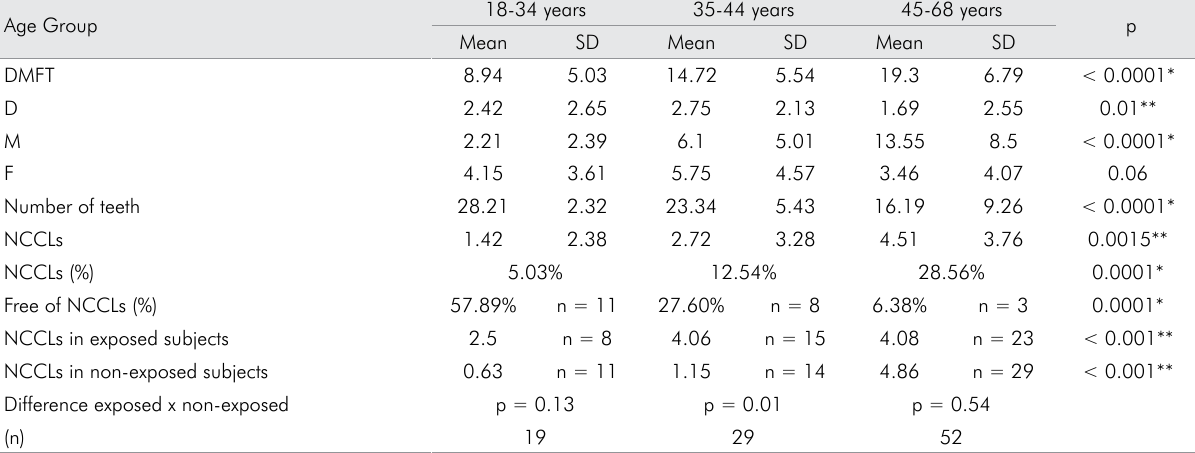
Table 2. Mean DMFT and NCCLs values (SD) according to age group.